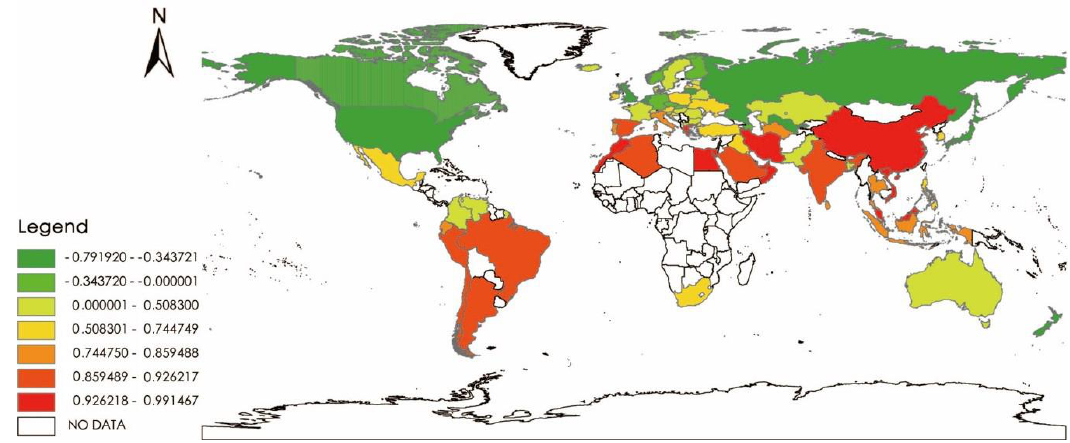
Figure 3. Correlation coefficients in the spatial dimension.